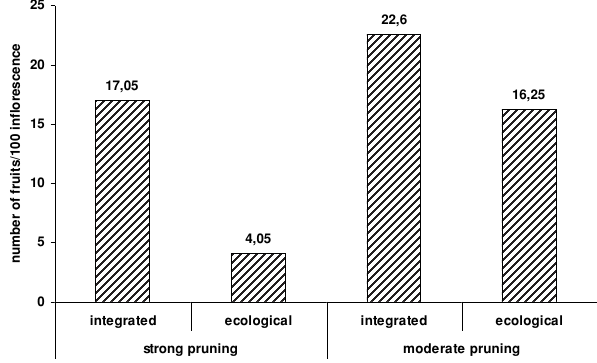
Figure 2. The effect of moderate pruning on fruit set on ‘Idared’ apple trees grafted on M 26 stock in integrated as well as in ecological growing systems, independently from the method of pruning techniques (Debrecen-Pallag, 2008)